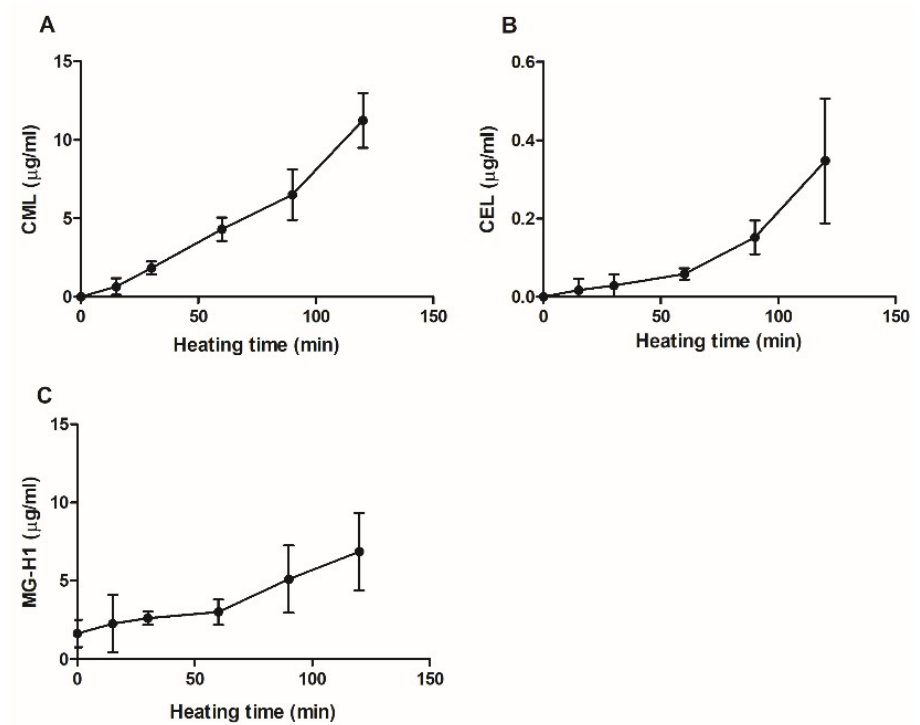
Figure 2. AGE-specific fluorescence of glycated casein measured at λ ex = 370 nm/λ em = 440 nm in relation to the heating time of the three components casein from bovine milk (10 g/L), lactose (0.2 M) and glucose (11 mM). Values were corrected for baseline fluorescence; the data are shown as mean ± SD, n = 3.